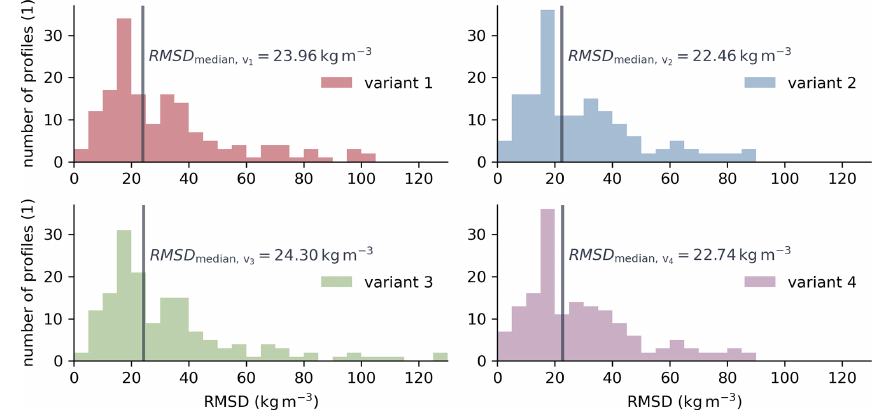
Figure 5. Distribution of smallest RMSD for every analyzed firn profile found using the optimization scheme outlined in Sect. 2.2. The four plots show the results for the four tested variants of the constitutive equation. Vertical lines indicate the median of the 159